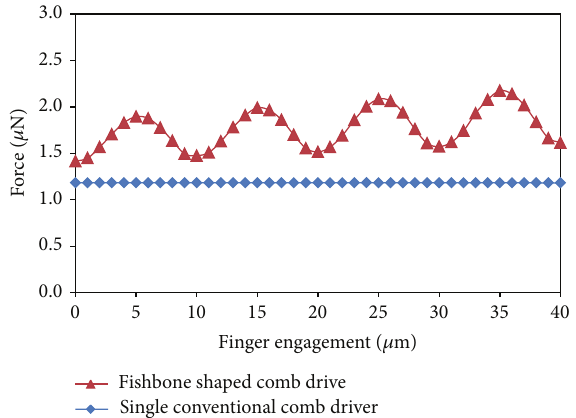
Figure 14: Comparison of force versus finger engagements for conventional comb driver and fishbone shaped comb